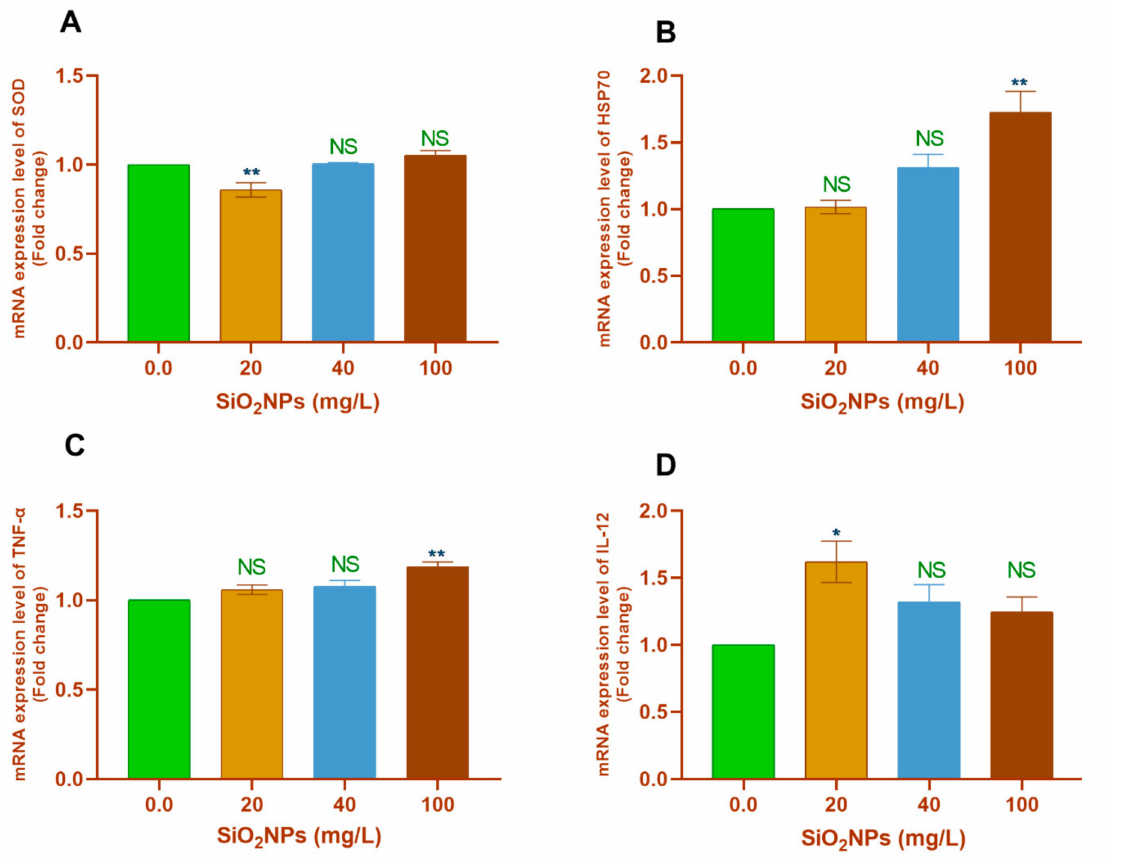
Figure 2. Transcription profile of ( A ) SOD , ( B ) HSP70 , ( C ) TNF- α , and ( D ) IL-12 genes in the gill tissues of Nile tilapia juveniles after exposure to different concentrations of SiO 2 NPs (0.0, 20, 40, and 100 mg/L) for 3 weeks. The values are expressed as mean ± SEM ( n = 9). Asterisks (**) ( p < 0.01) and (*) ( p < 0.05) indicate significant differences between the exposure groups as compared with the control group. NS indicates non-significant